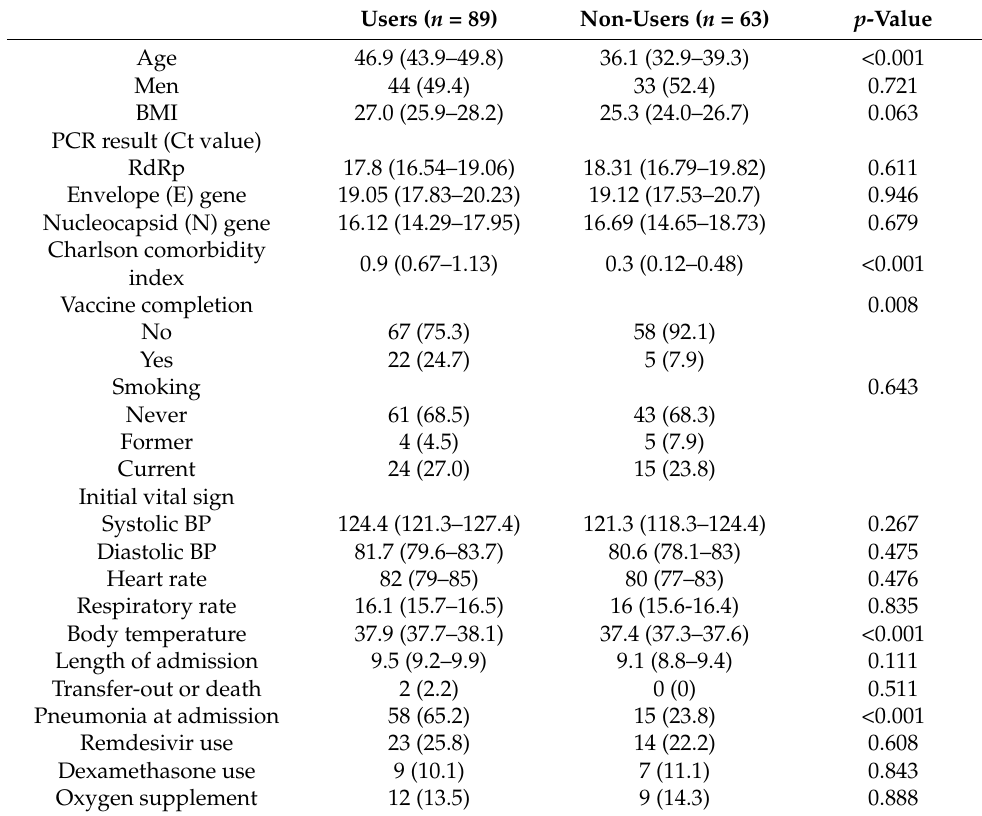
Table 1. Clinical characteristics according to regdanvimab